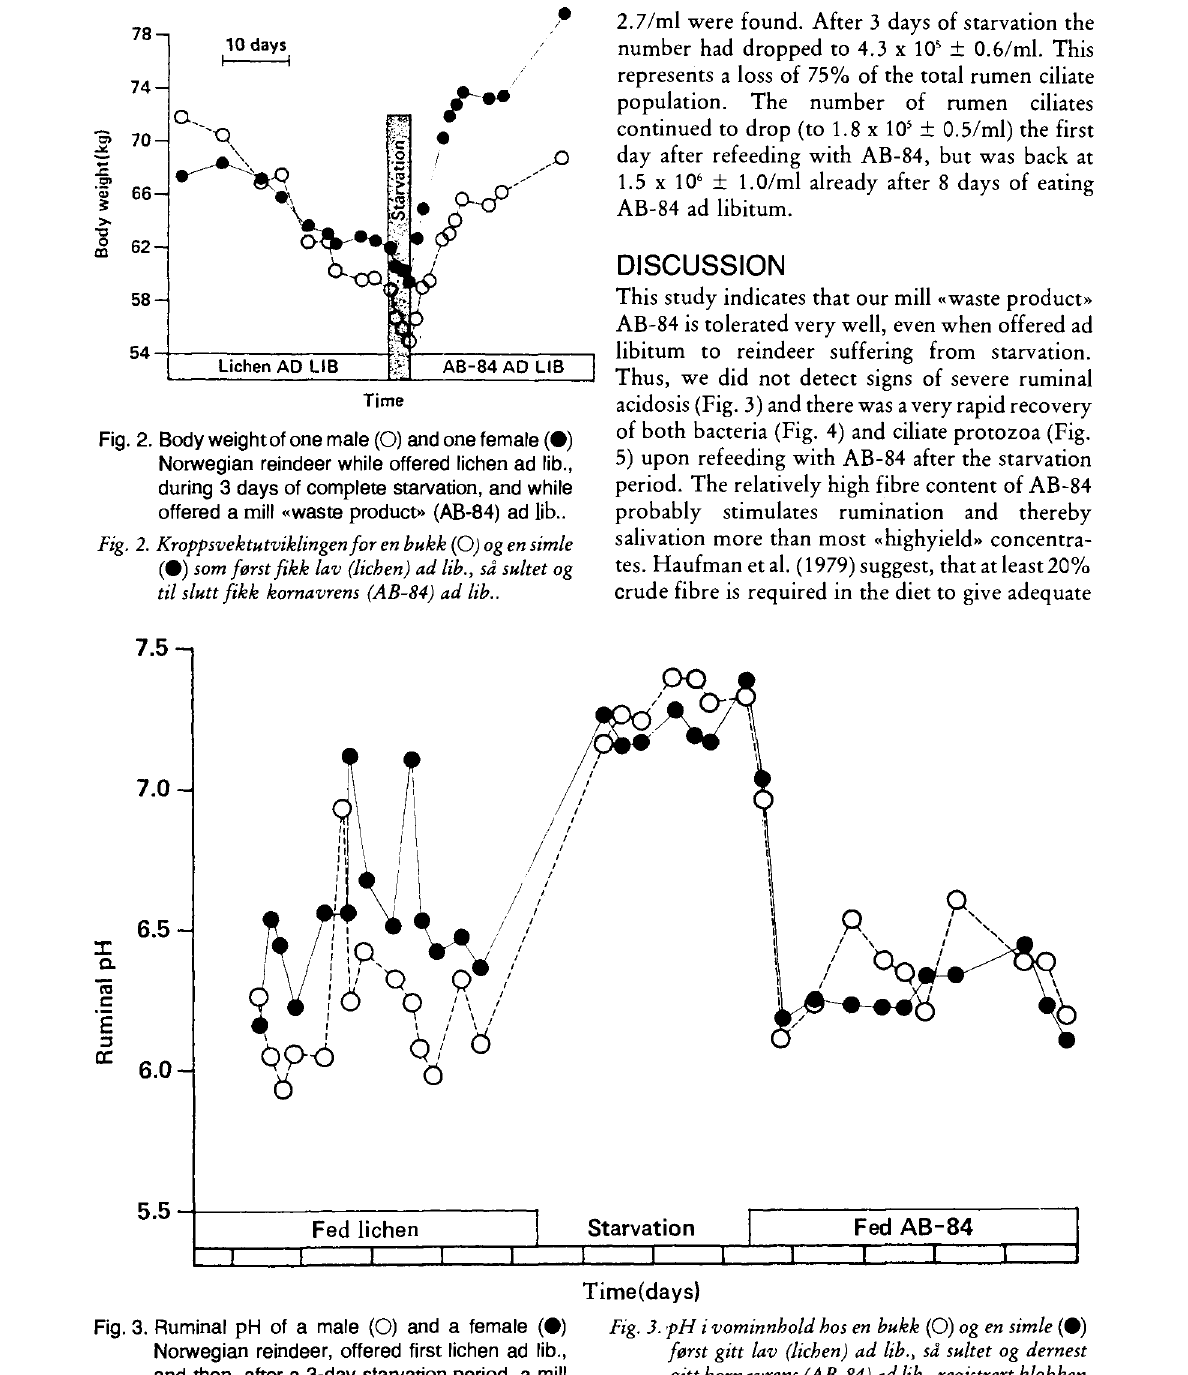
Fig. 3. Ruminal pH of a male (O) and a female (•) Norwegian reindeer, offered first lichen ad lib., and then, after a 3-day starvation period, a mill «waste product" (AB-84) ad lib. Measurements were made at 0900, 1200, 1500 and/or 2000